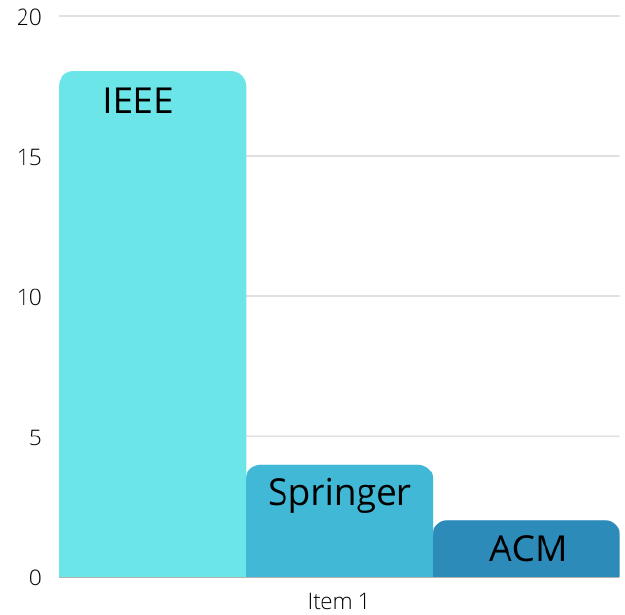
Figure 4. Distribution of conference